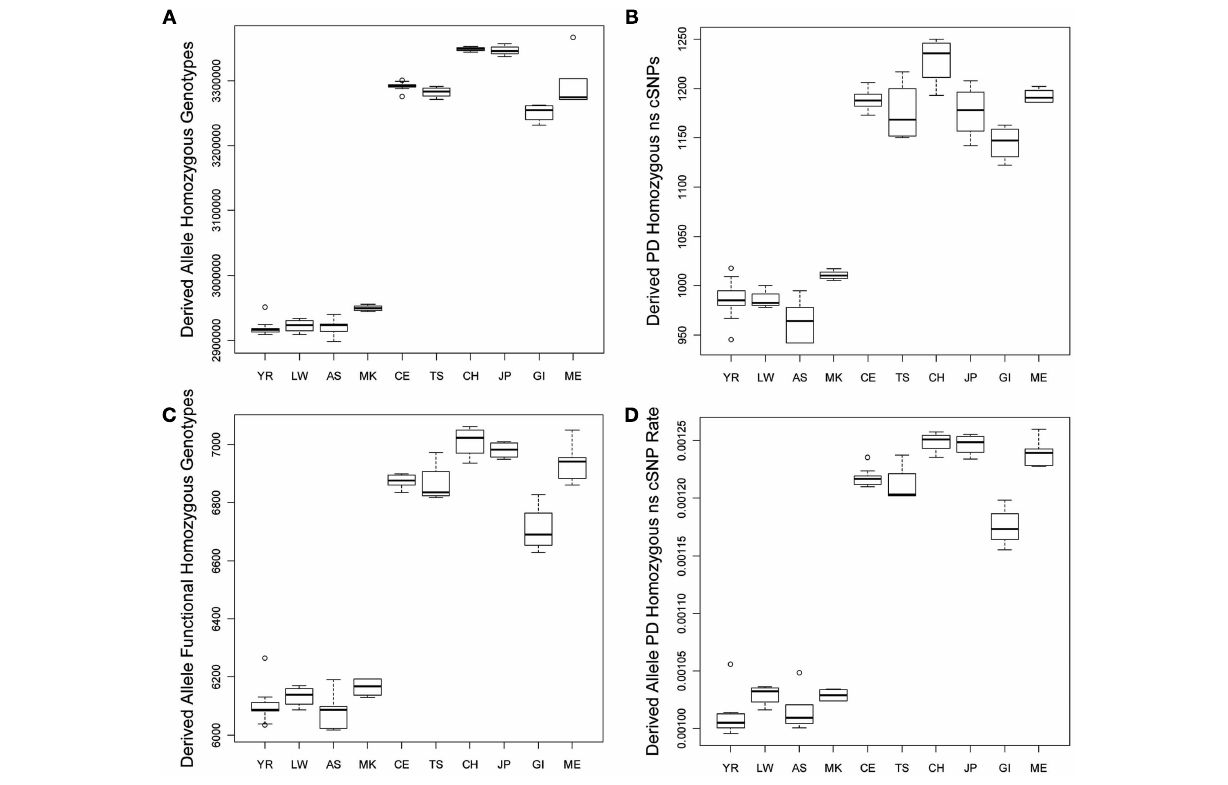
FIGURE 2 | Boxplots reflecting the differences in the number and rates of specific variant types across the 10 populations. (A) Number of loci on individual genomes that are homozygous for a derived allele; (B) Number of coding loci on individual genomes that are homozygous for a derived allele that results in a non-synonymous amino acid substitution that is predicted to